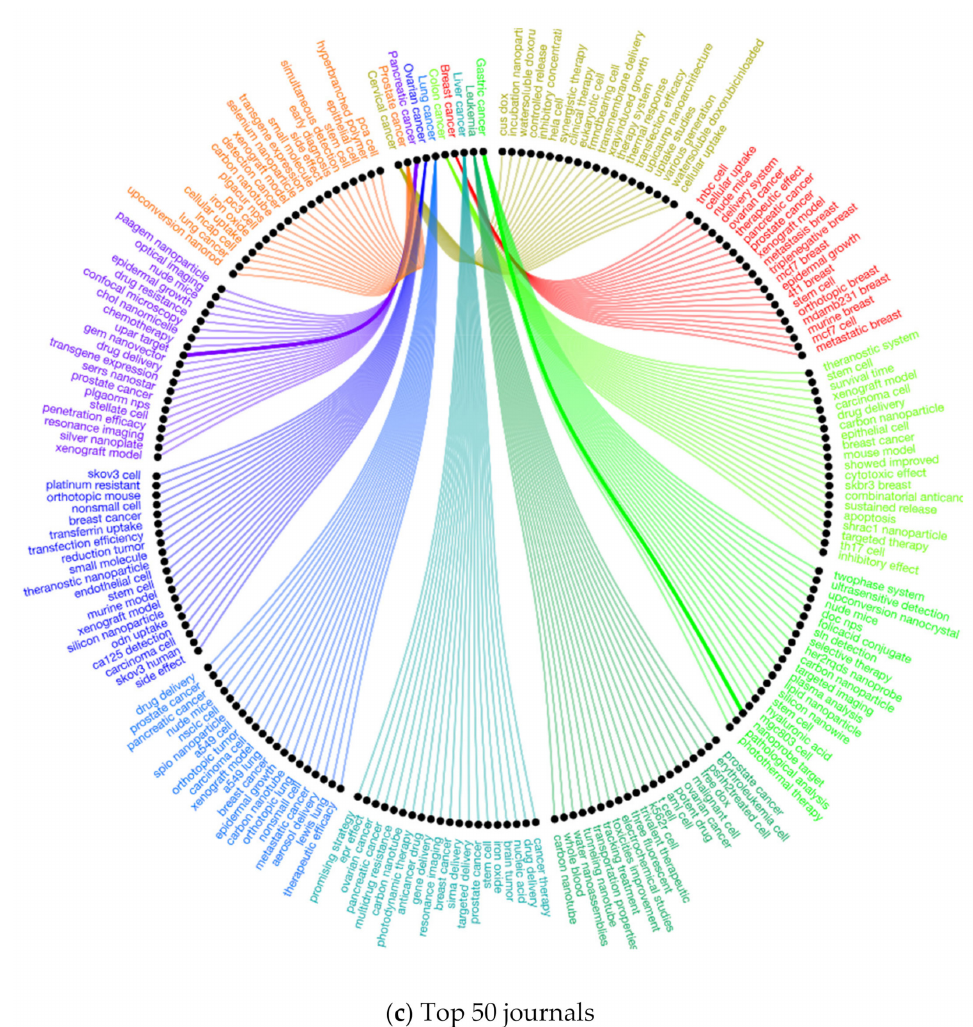
Figure 10. Circos plot of research areas in top 10 cancer types for the three scenarios: ( a ) entire dataset, ( b ) top 100 journals, and ( c ) top 50 journals. For better image quality, readers are encouraged to check the URL: https://1data.life/pages/publication/Cancer%20Nanotechnology.html (accessed on 20 August